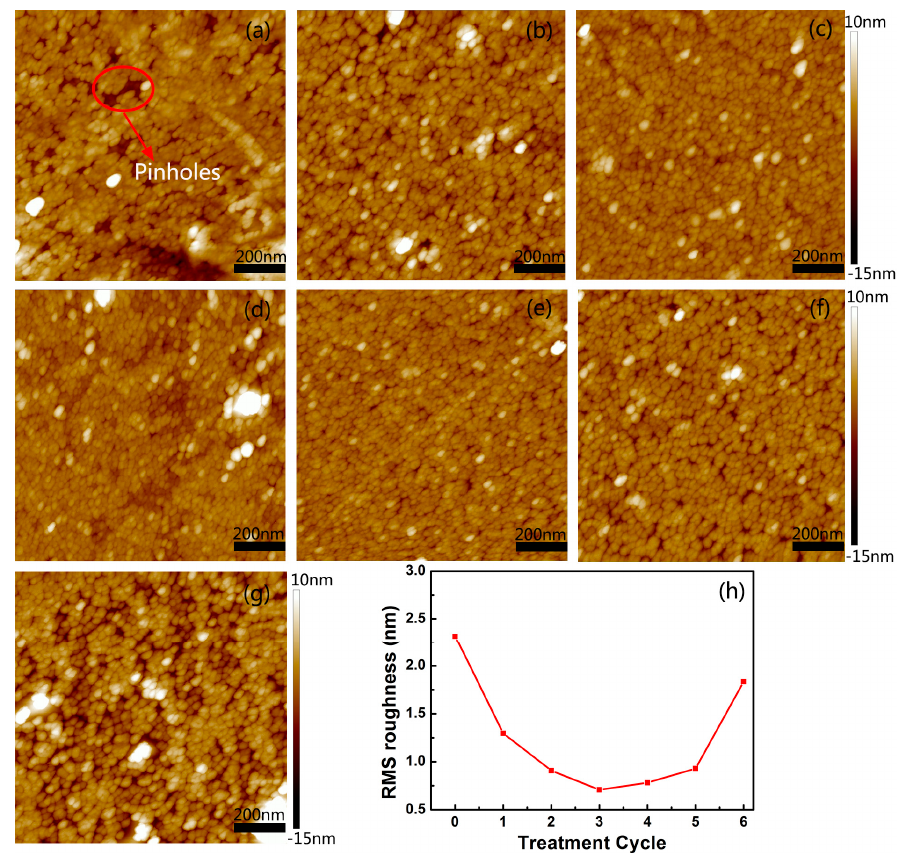
Figure 1. AFM images of ZrO 2 seed layers on graphene with different cycles of H 2 O treatment at 100 ◦ C: ( a ) 0; ( b ) 1; ( c ) 2; ( d ) 3; ( e ) 4; ( f ) 5; and ( g ) 6 cycles; ( h ) The RMS roughness of the ZrO 2